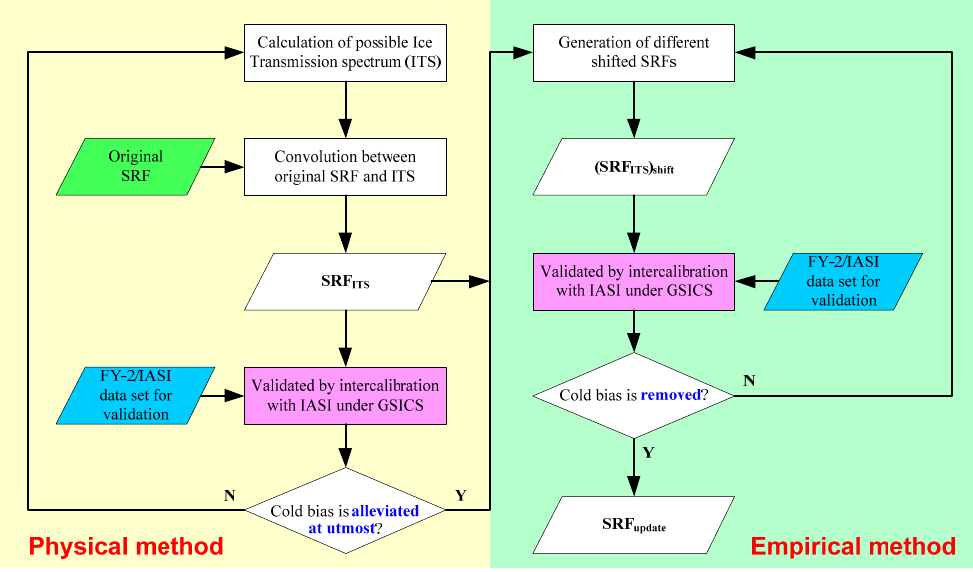
Figure 5. Main sketch of the approach combining both physical and empirical methods for SRF correction of the FY-2G IR2 band.